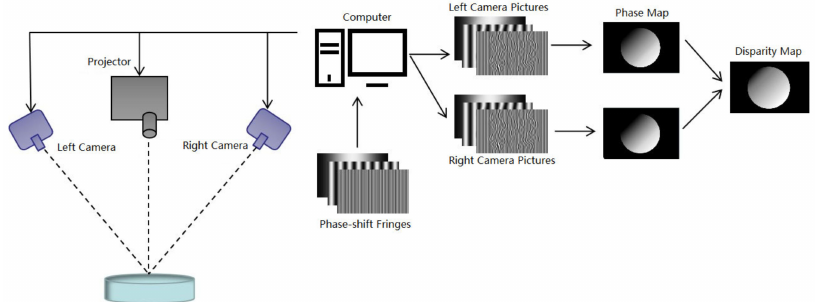
Figure 2. Structured light binocular vision measurement diagram.